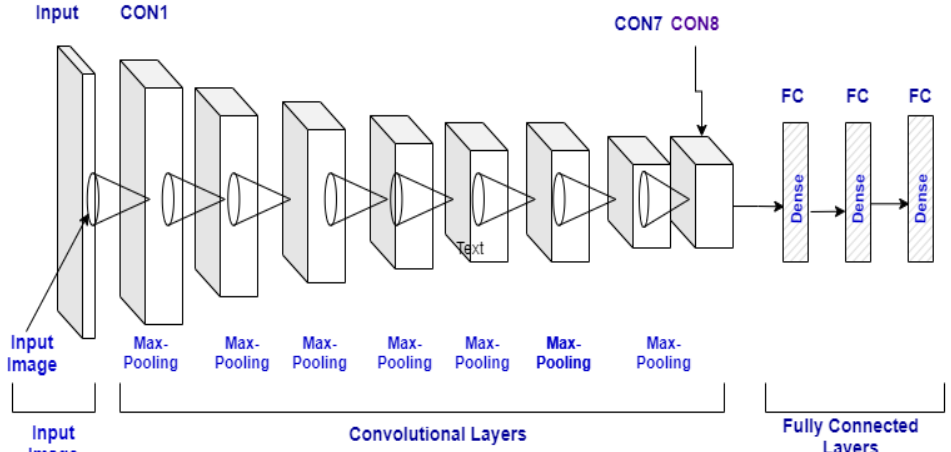
Figure 3. CNN model architecture. Table 1. Hyper-parameter of deep neural network.